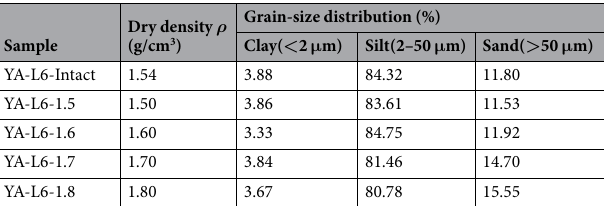
Table 4. Dry density and grain-size distribution of the